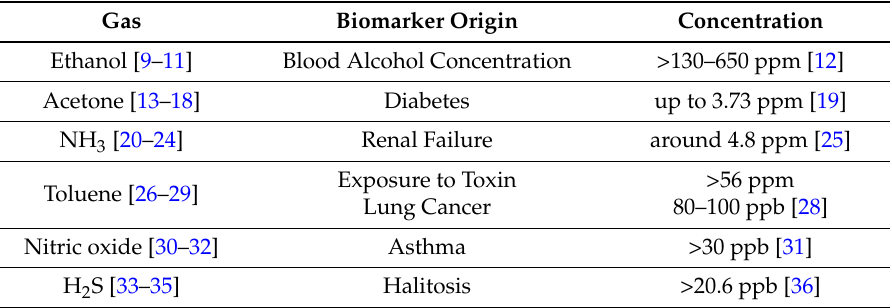
Table 1. In this table different breath analysis relevant gases which have reportedly been detected using WO 3 -based sensors are